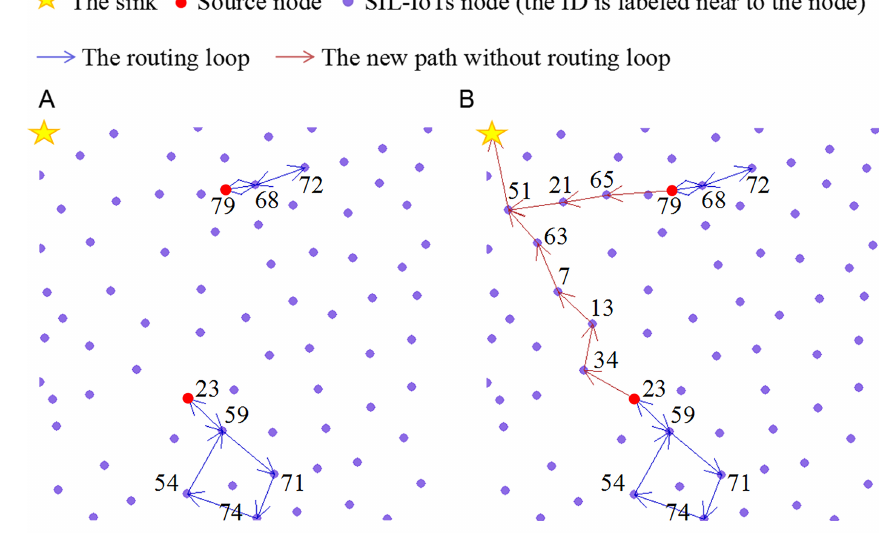
Figure 9. Two routing-loop situations occur in THECB during the simulation. ( A ) the routing loop: 79 → 68 → 72 → 68; 23 → 59 → 71 → 74 → 54 → 59. ( B ) the new path without loop: 79 → 65 → 21 → 51; 23 → 34 → 13 → 7 → 63 →